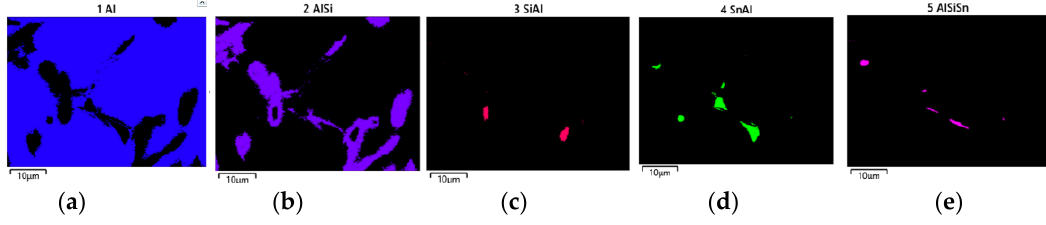
Figure 19. Phase distribution maps for AlSi10Sn1.7: ( a ) Al; ( b ) AlSi; ( c ) Si; ( d ) SnAl; ( e ) AlSiSn.